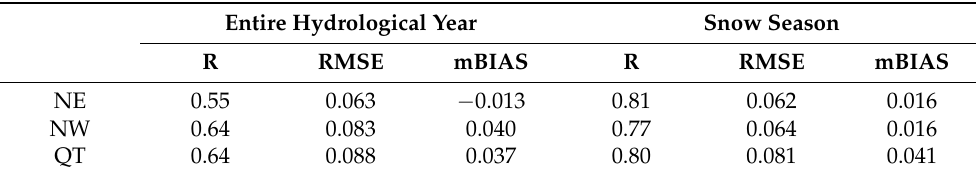
Table 1. Mean values of the accuracy indicators of snow cover consistency in three test regions across the entire hydrological year and snow season. Note: The raw NDSI values from 0 to 1 were used for calculations. Entire Hydrological Year Snow Season